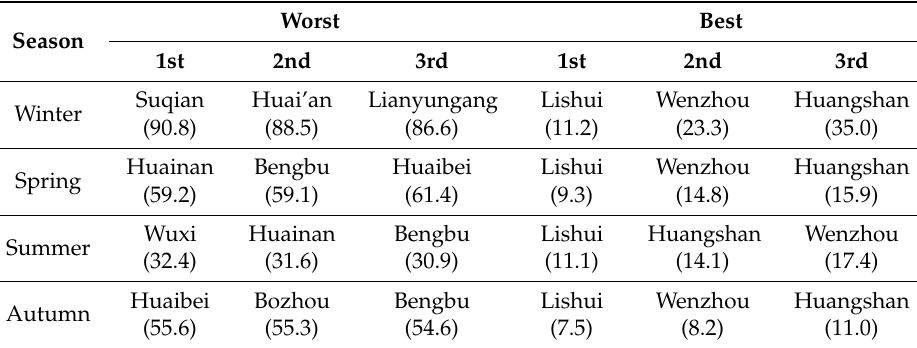
Table 10. The top three cities with the best or the worst air